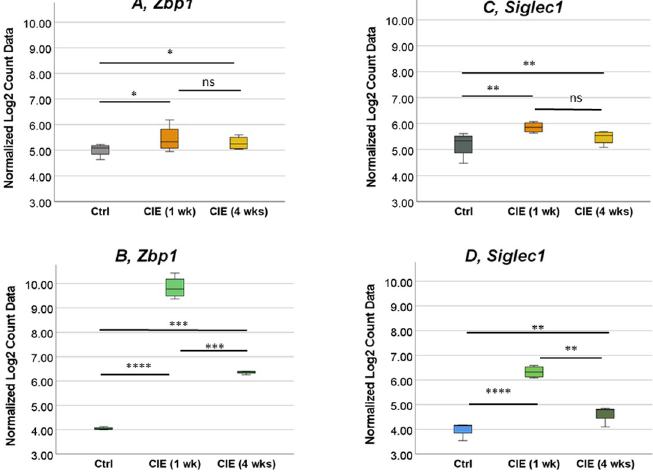
Fig 7. Up-regulation of Zbp1 and Siglec1 genes in both, SC and UB, samples from CIE mice. The two genes, Zbp1 (A and B) and Siglec1 (C and D), were upregulated in both, SC (B and D) and UB (A and C), specimens in CIE mice. � p � 0.05, �� p � 0.01, ��� p �